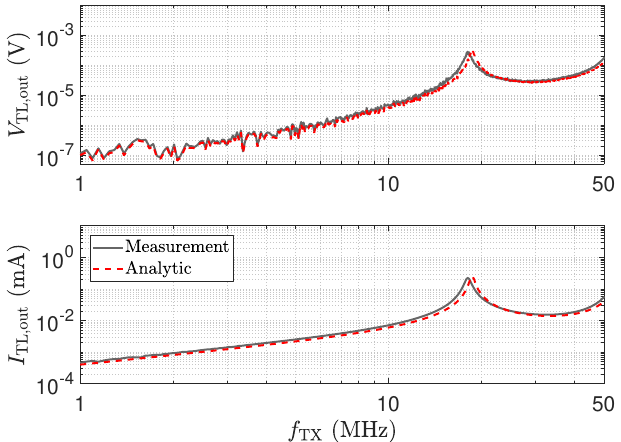
Figure 14. Voltage and current peaking at the output of a 2.5m long transmission line, as depicted in Figure 10. The measurement result of a direct attached assembly ( l cable = 0m), shown in Figure 11, is used to determine the trends denoted by “Analytic”, according to Equations (14)–(16), with G (cid:48) = 0 S R (cid:48) = 1 Ω , L (cid:48) = 250 nH and C (cid:48) = 100 pF . The frequency responses marked by “Measurement” are m m m determined by the use of the transfer coefficient S 21 in Figure 13.